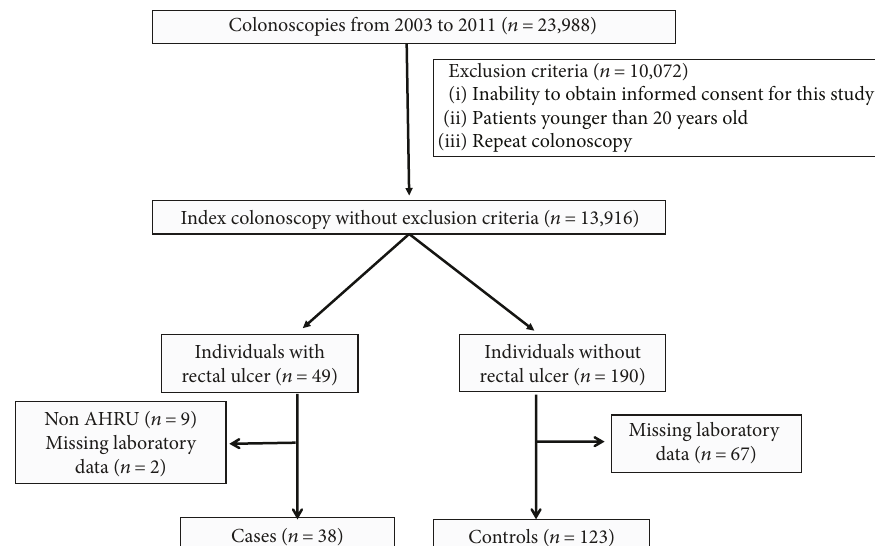
Figure 1: Study fl ow diagram depicting selection of cases and controls. 13,916 index colonoscopies out of 23,988 were performed in the patients older than 20 years of age in a tertiary medical center in Tokyo, Japan. Thirty-eight acute hemorrhagic rectal ulcer syndrome patients were diagnosed. From the same database of index colonoscopies, 123 patients without rectal ulcer were selected as a control group by risk set